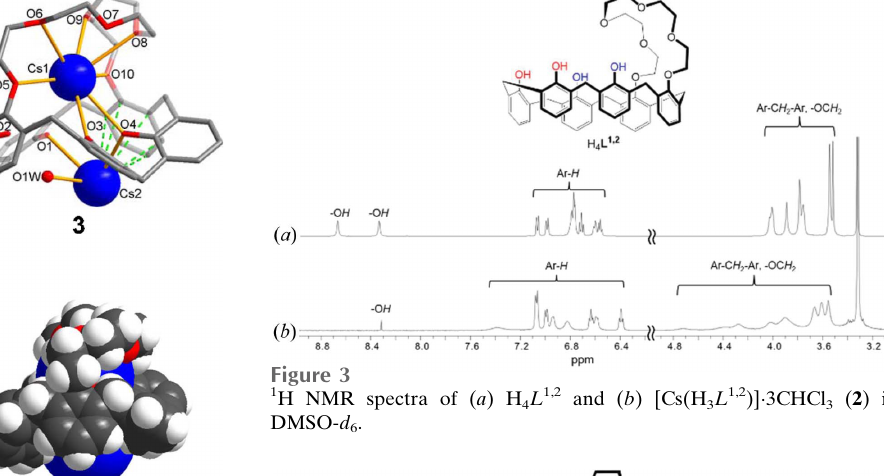
1,2 and ( b ) [Cs(H 4 L